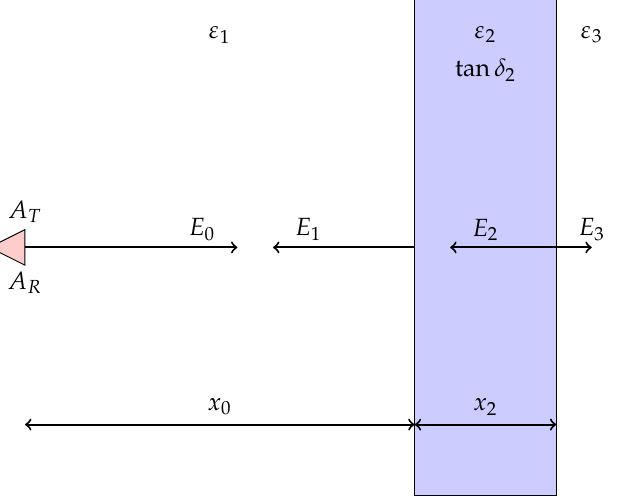
Figure 4. Three-layer model with an object representing one layer of dielectric